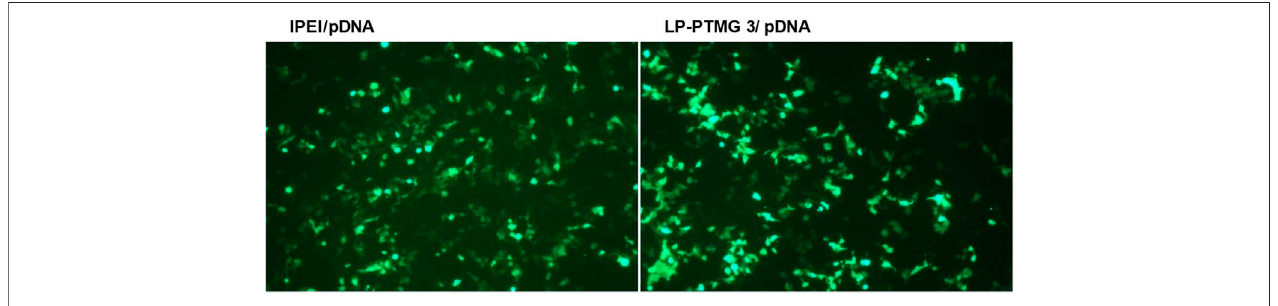
FIGURE 7 | Fluorescence images observed on transfection of Hela Cells with lPEI/pDNA and LP-PTMG/pDNA complexes at w/w ratio of